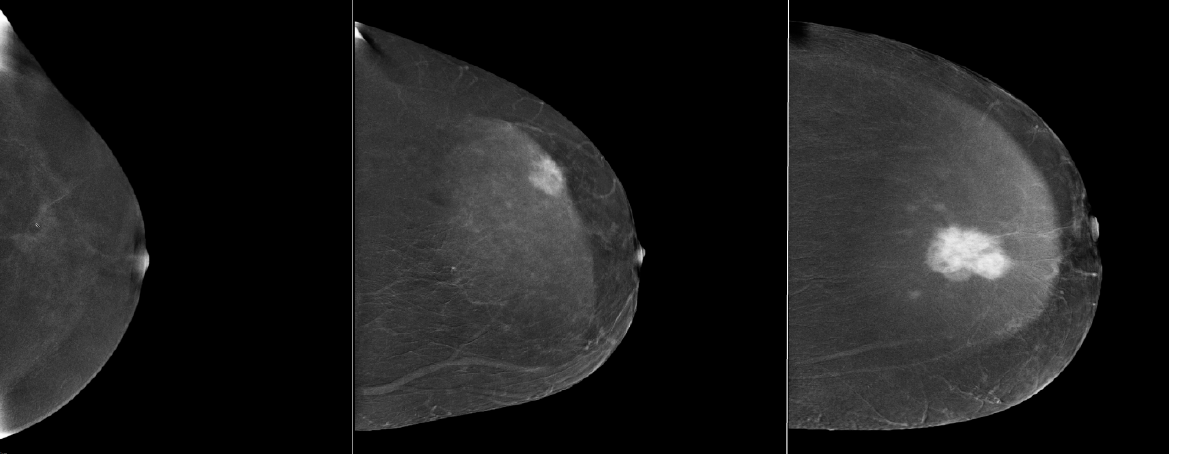
Figure 2. Qualitative assessment of the enhancement level on CEM (weak, medium and strong enhancement levels of suspicious breast lesions).